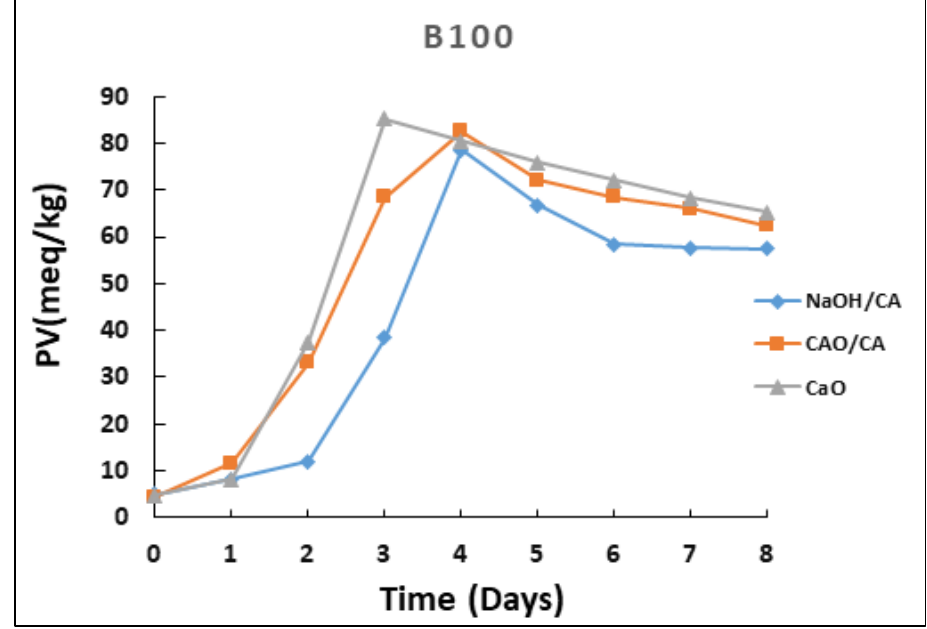
Figure 4. Peroxide value of B100 on different days under accelerated storage at 63 °C.